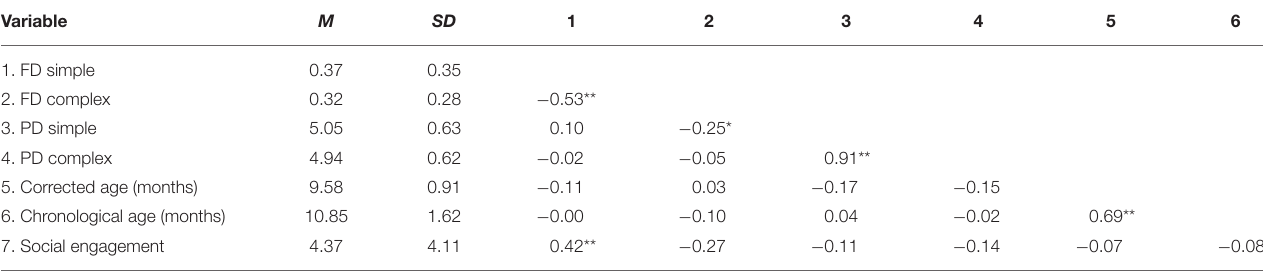
TABLE 3 | Correlation matrix and demographic information.